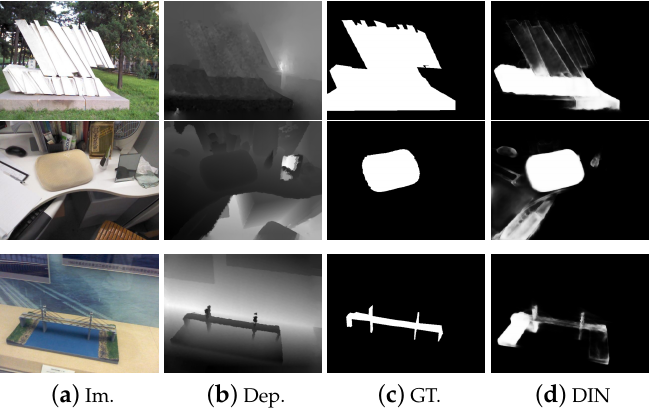
Figure 7. Failure cases of our method. ( a ) Input image; ( b ) depth image; ( c ) ground truth; ( d ) the proposed